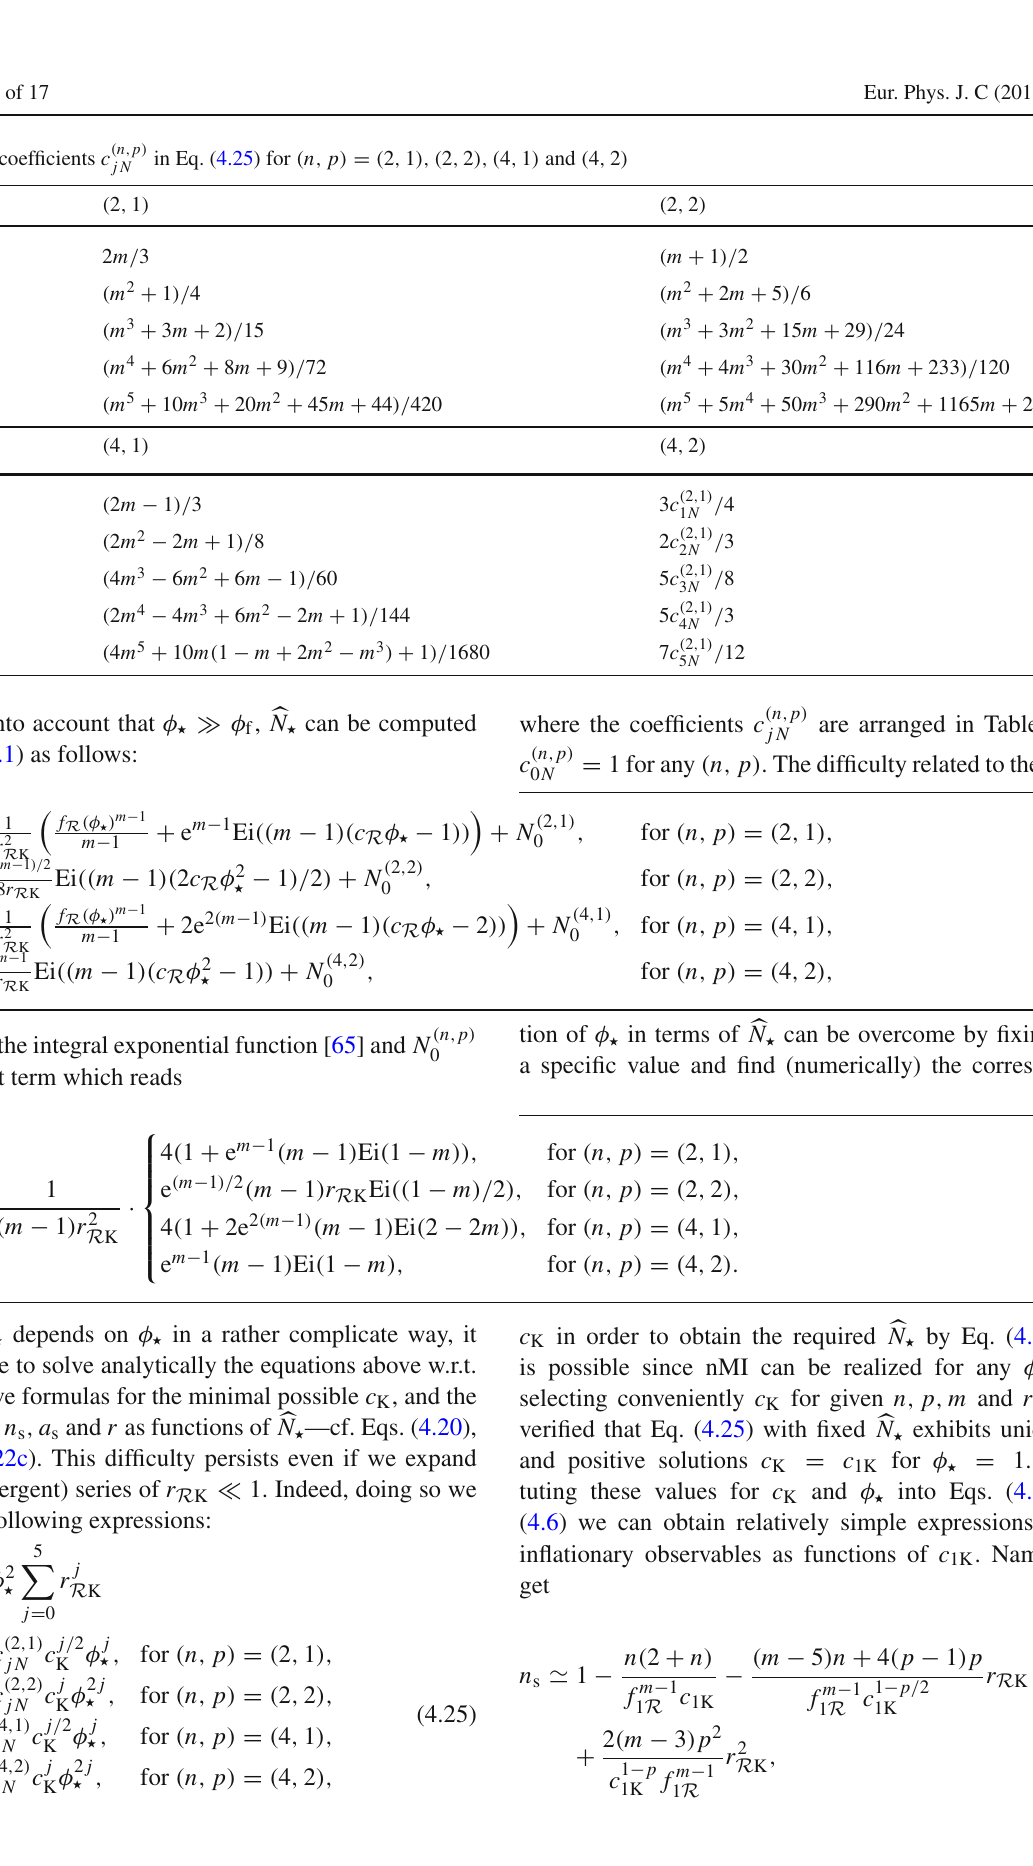
Table 3 The coefficients c